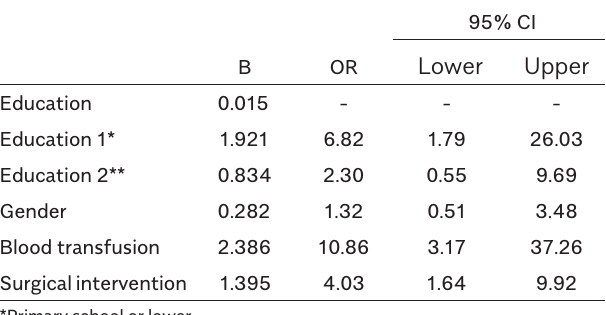
Table 2. Multivariate Analysis of Factors Affecting HCV Genotype 4 Infection